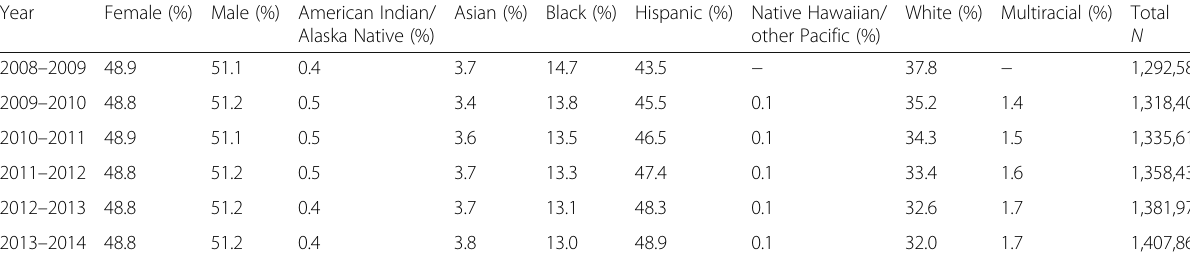
Table 3 Texas high school students ’ demographic characteristics from 2008 to 2013 school years Year